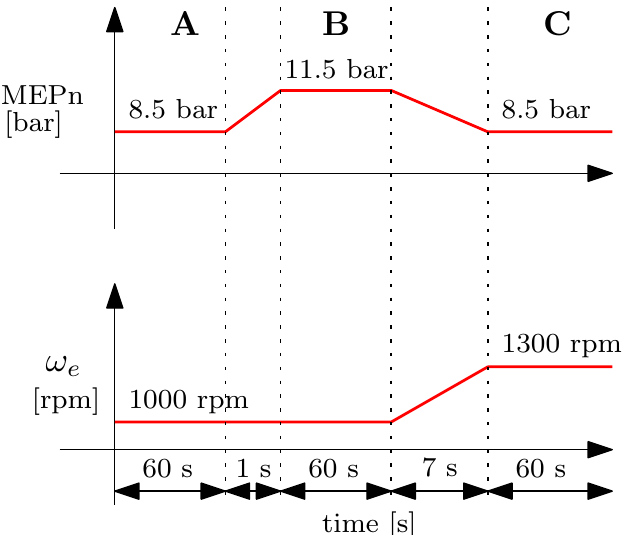
Figure 8. Test cycle around the three studied operating points for evaluation of transient RCCI engine performance. Reprinted from [19] with permission of the International Federation of Automatic Control